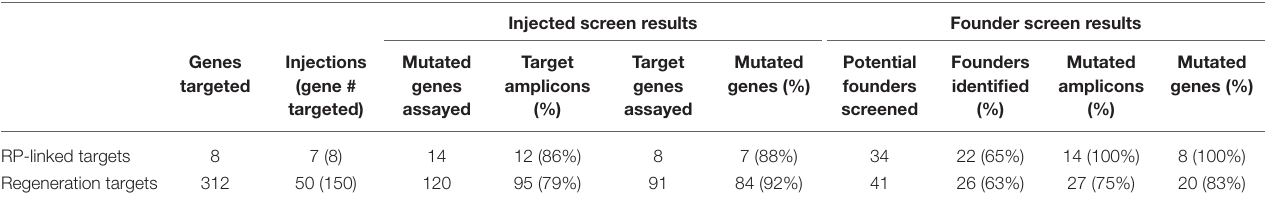
TABLE 2 | Mutagenic efficiencies observed in injected F0 embryos and F1 founder